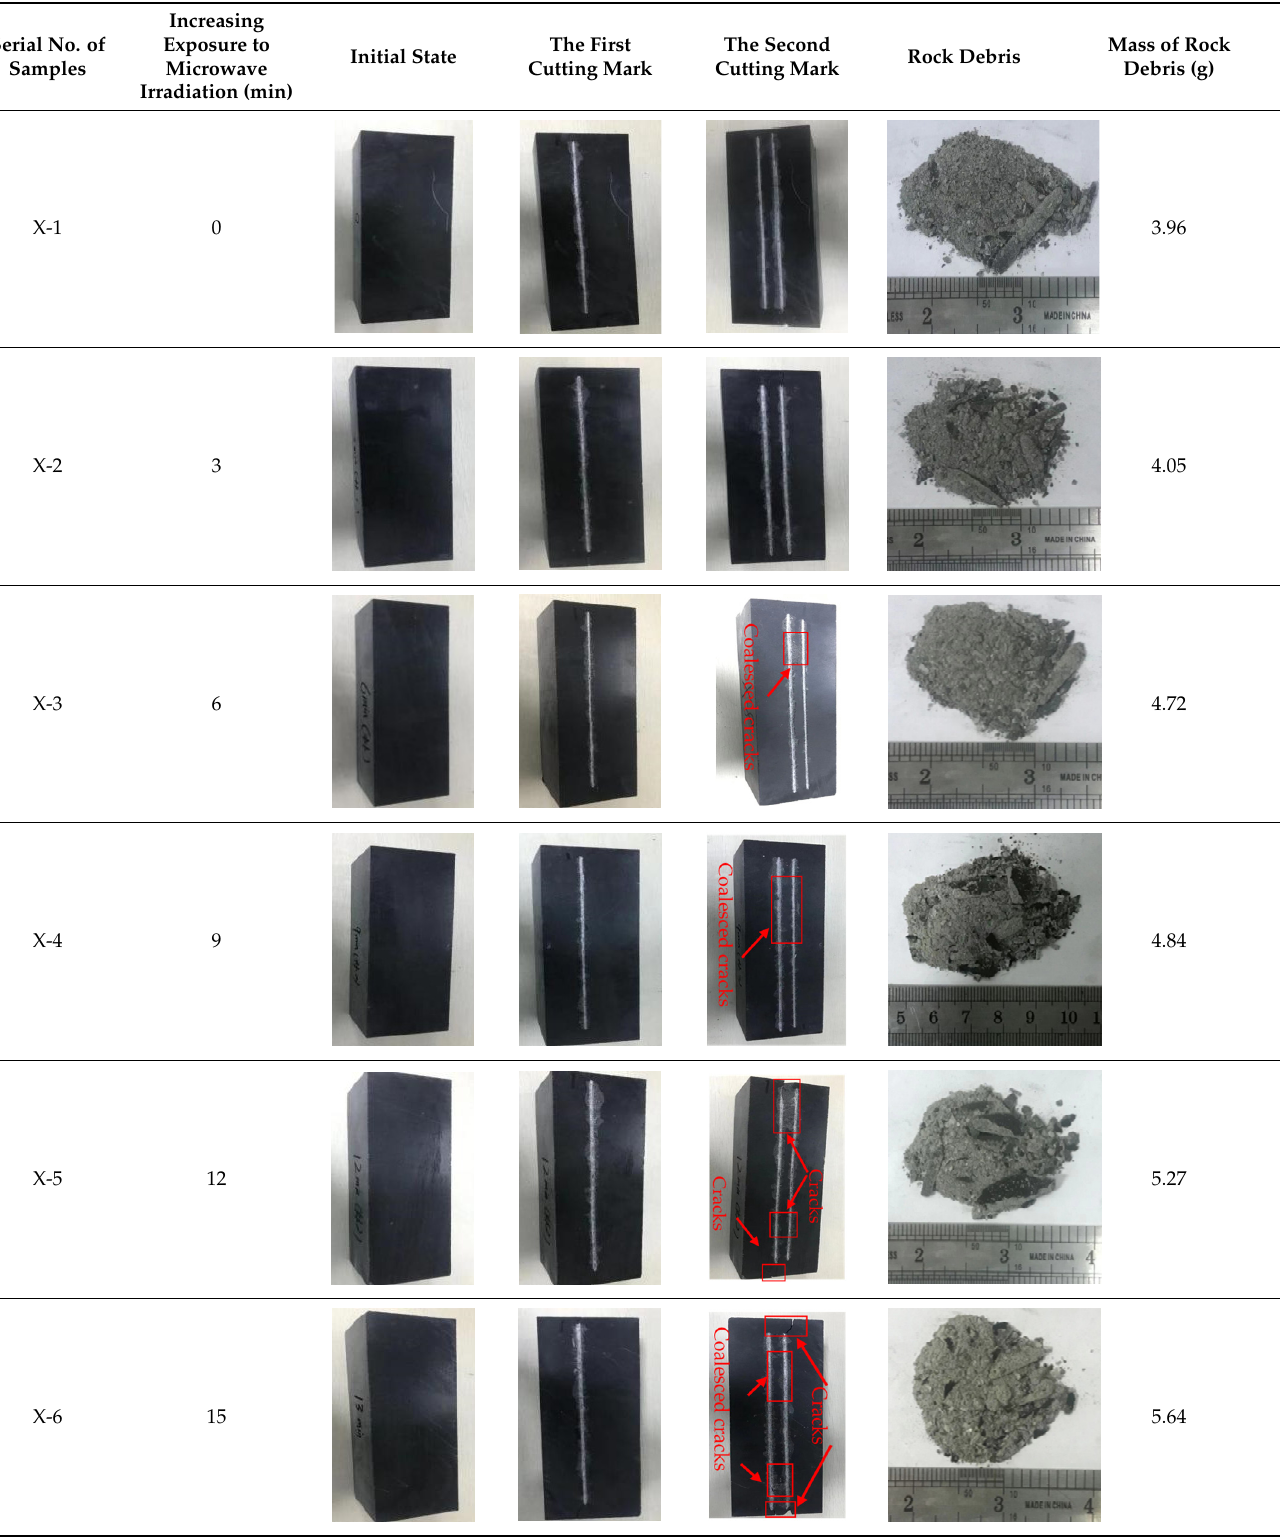
Table 2. Cutting effects of the reduced-scale TBM cutter on the samples subjected to different durations of microwave irradiation.